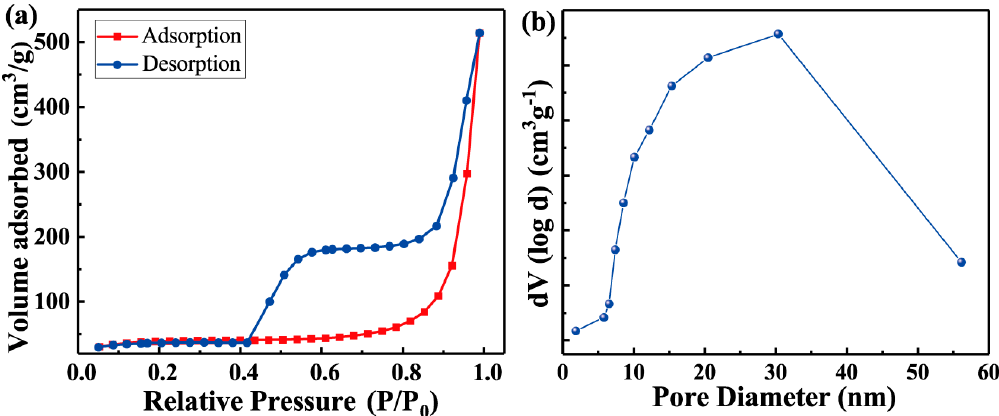
Figure 4. ( a ) Isothermal adsorption/desorption curve, ( b ) pore diameter distribution of ZnO/GO NSs- 525.